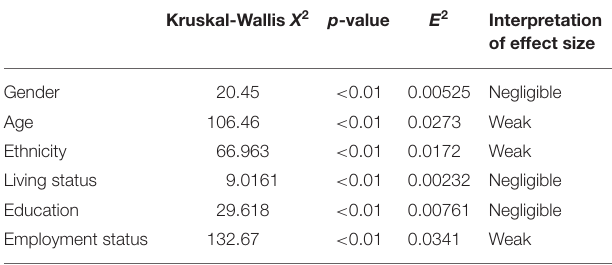
TABLE 3 | Results of Kruskal-Wallis ANOVA examining PHQ-9 total score across demographic